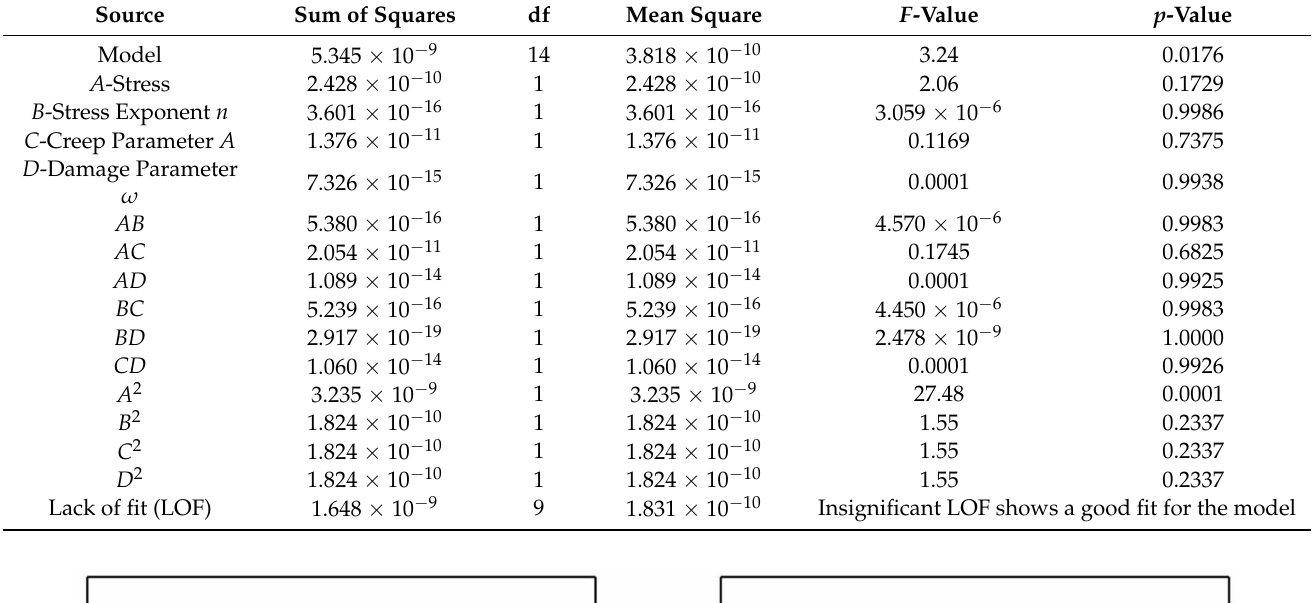
Table 7. ANOVA for the quadratic model (response: strain, ε ).